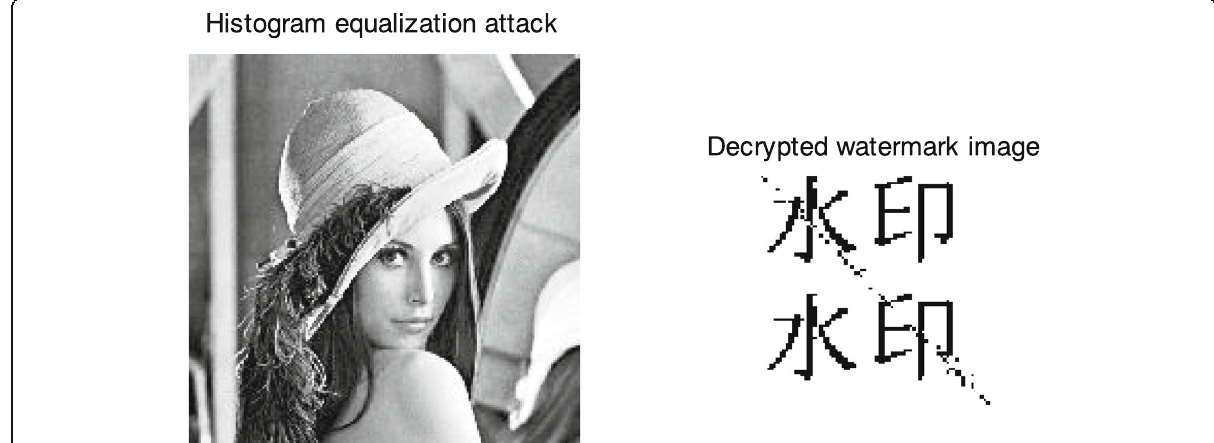
Fig. 14 Histogram equalization attack and decrypted